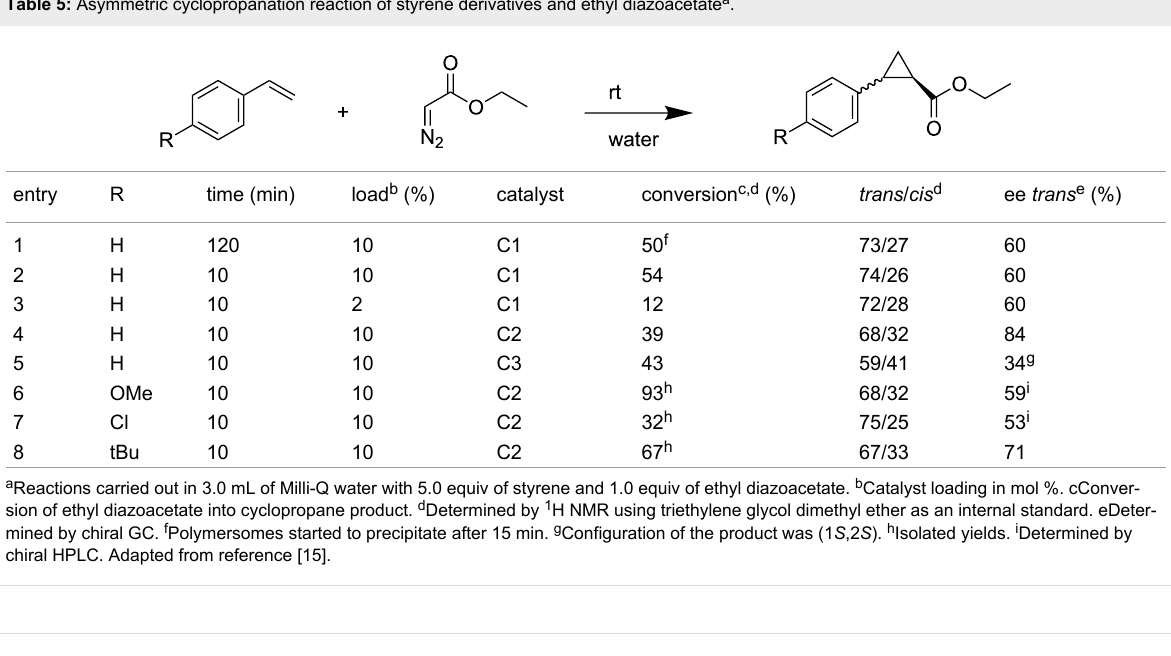
Table 5: Asymmetric cyclopropanation reaction of styrene derivatives and ethyl diazoacetate a .